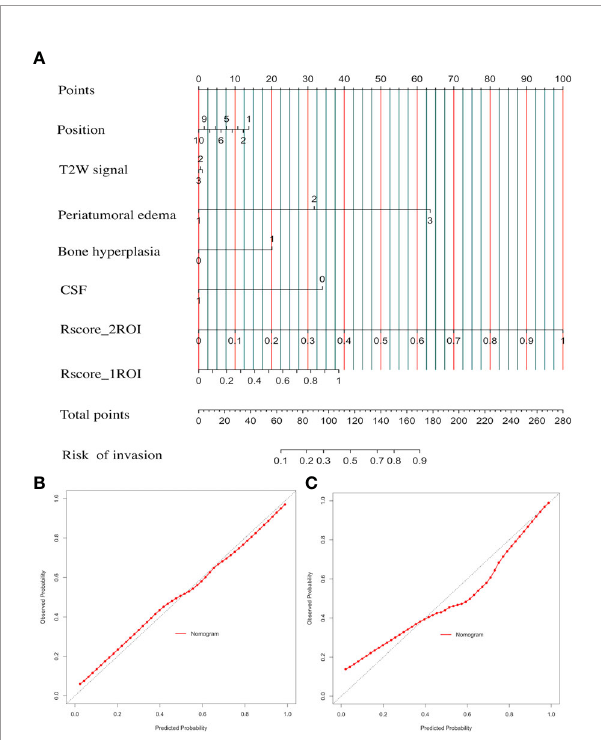
FIGURE 6 | Clinical semantic and radiomics nomogram (CSRN) and its calibration curves. (A) Nomogram; (B) correction curve of the training set; (C) calibration curves of the test set.